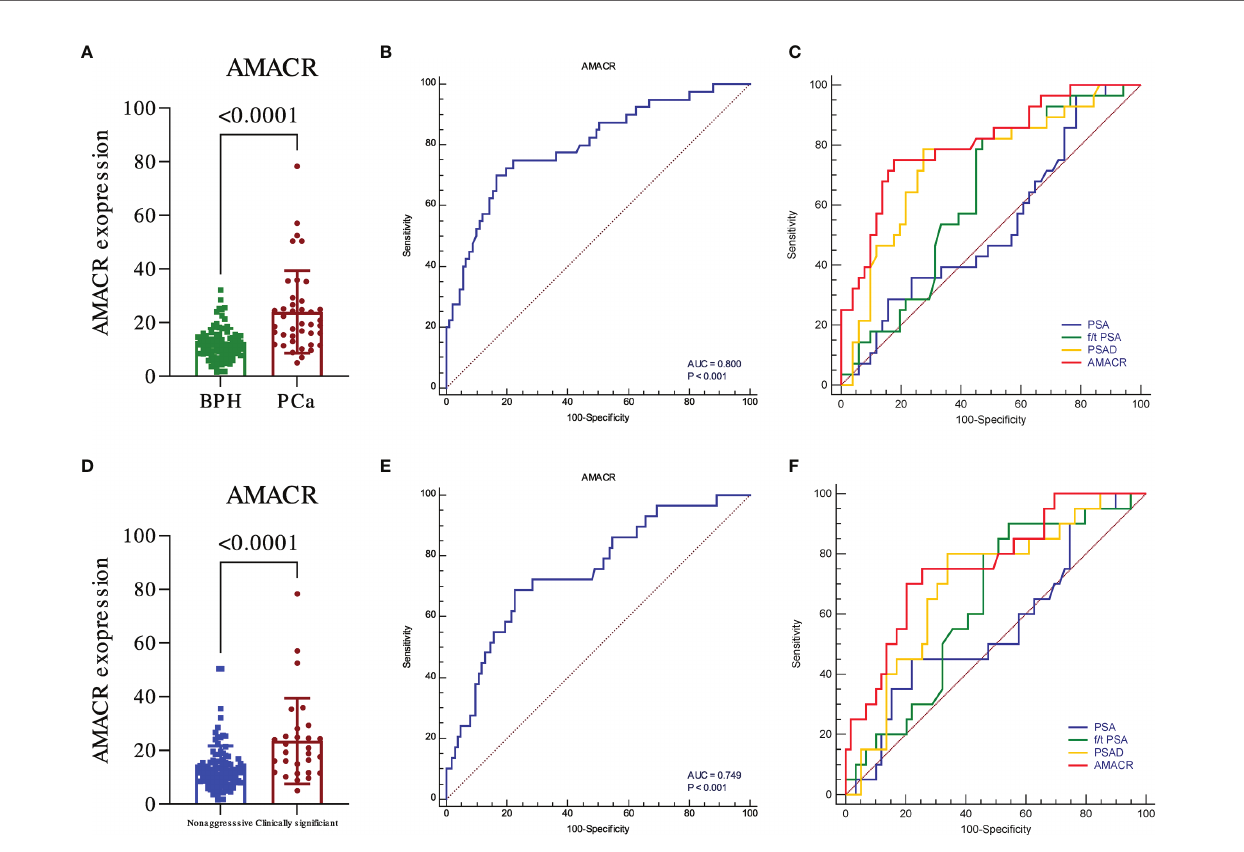
FIGURE 2 | The diagnostic utility of urine exosomal AMACR in the validation cohort. The urine AMACR was signi fi cantly higher in the PCa (A) (p < 0.001) and csPCA (D) (p < 0.001) than the control group, respectively. The utility of urine AMACR in distinguishing PCa (B) (AUC: 0.800, p < 0.001) and csPCa (E) (AUC: 0.749, p < 0.001). Comparison ROC illustrated that the urine AMACR has a better performance than PSA, f/t PSA, and PSAD in PCa (C) and csPCa (F) diagnosis.